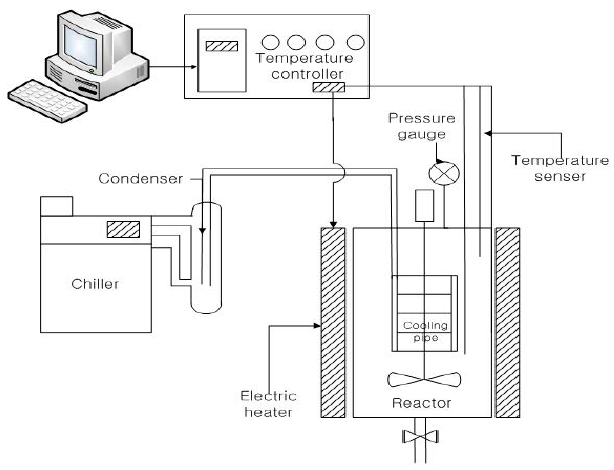
Figure 2. Schematic diagram of the lab-scale HTC batch reactor.